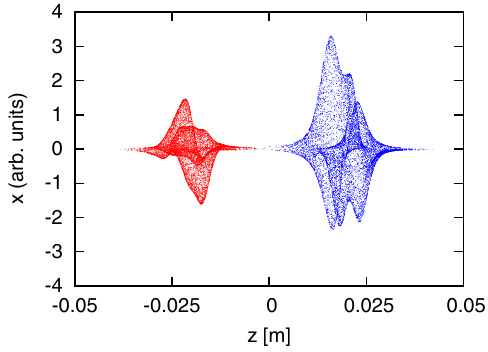
FIG. 11. Beam distribution in the x − z plane at the collision ð − Þ ¼ 0 . 57 and ν ðþÞ ¼ 0 . 53 (SuperKEKB), where point for ν x x θ ¼ 8 , ξ ðþÞ ¼ 0 . 0174 , ξ ð − Þ ¼ 0 . 0099 , ν ðþÞ ¼ 0 . 0244 , and ν ð − Þ z x x P 0 . 028